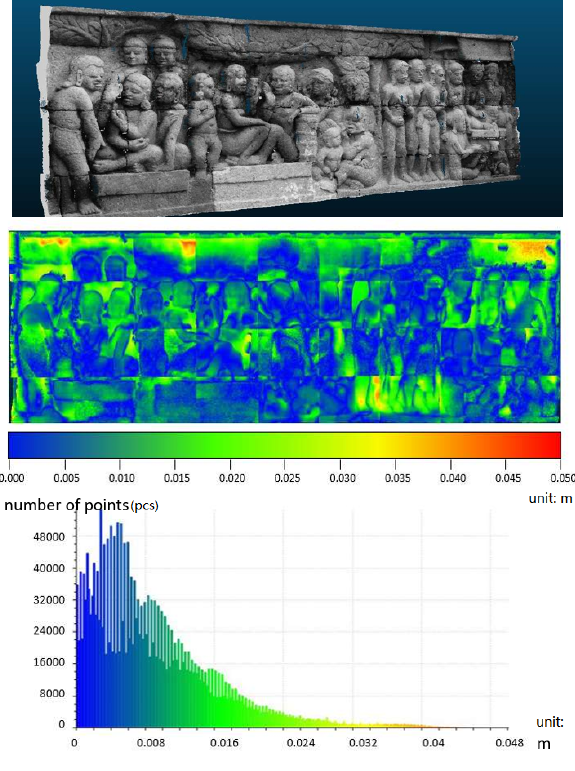
Figure 7. Reconstruction result (test